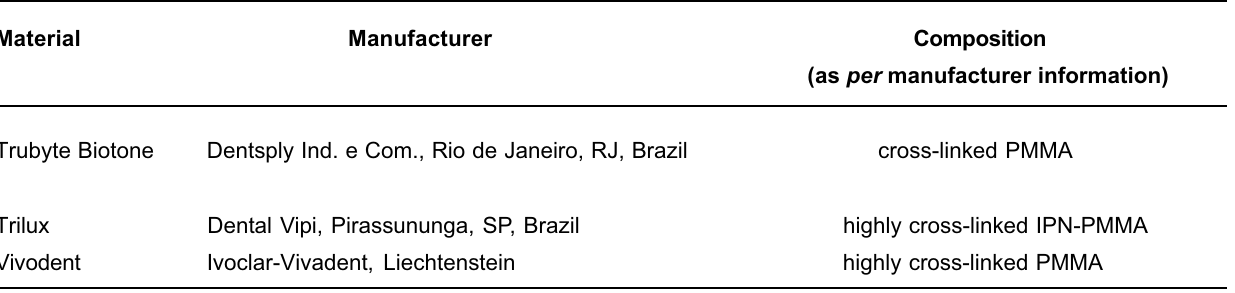
TABLE 1- Tested polymethyl methacrylate denture